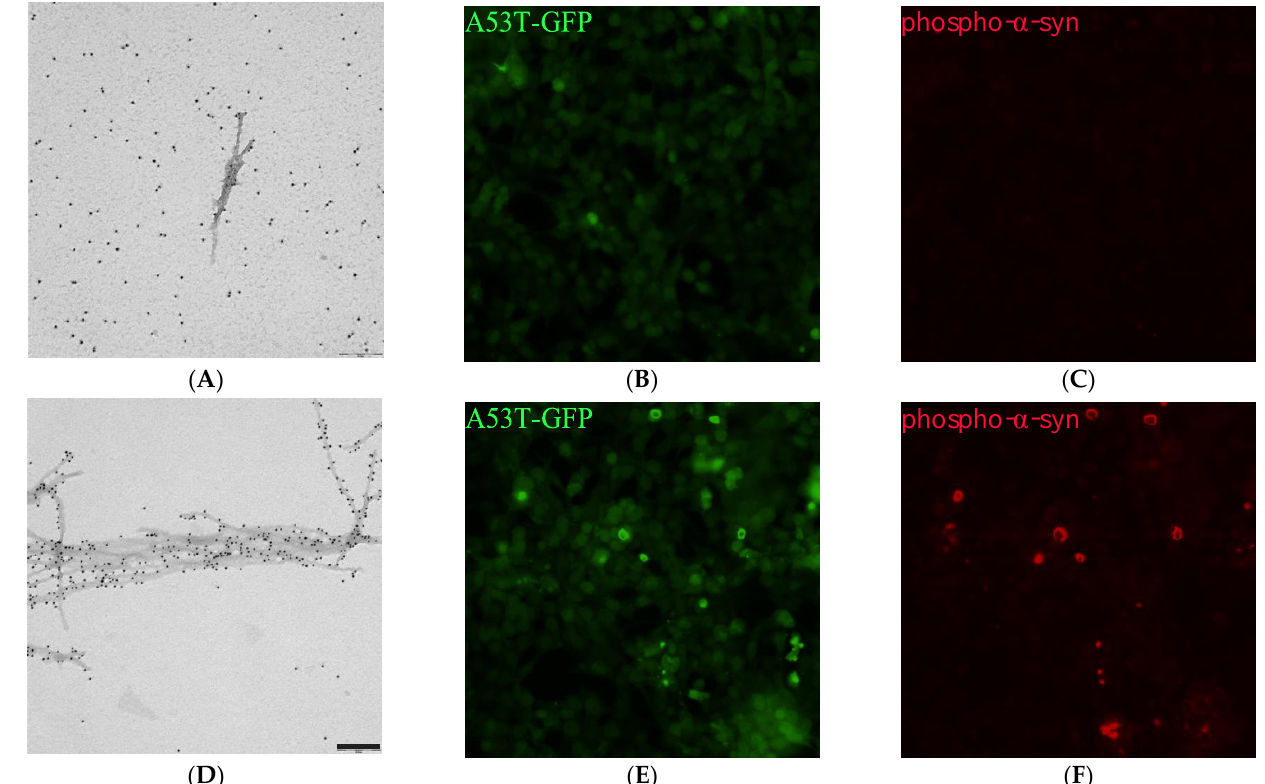
Figure 3. Microscopic images. ( A , B ) TEM micrographs at 60,000 times magnification of samples taken at the plateau of aggregation reactions with 25 μM α -syn ( A ) in the absence or ( B ) presence of 9 μM PSMα1 peptide. All experiments started from monomers and were performed in 10 mM Tris, 50 mM NaCl, 1.1% DMSO, pH 7.6 at 37 °C under quiescent conditions. After deposition on the grids, the samples were labelled by an anti- α -syn primary antibody (syn211) and a secondary antibody linked to 10 nm gold nano-particles. Scale bar = 200 nm. ( C – F ). GFP and Cy-3 fluorescence microscopic images at 20 times magnification of HEK cells expressing A53T α -syn fused to GFP. The same samples as imaged by TEM were sonicated and added at a 1:10 ratio to the cells for 48 h before the cells were fixed and incubated with an antibody against phosphorylated α -syn followed by a Cy3-conjugated secondary antibody.